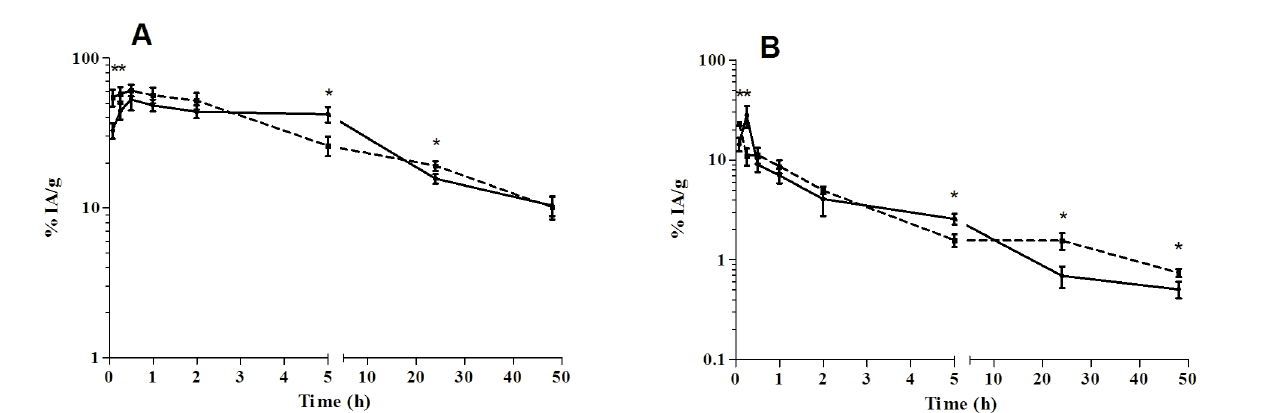
Figure 2 Antimony biodistribution in uninfected [22] and L. ( L. ) amazonensis -infected BALB/c mice after intraperitoneal administration of meglumine antimoniate. A : liver; B : spleen. Continuous line: infected mice; dotted line: uninfected mice. Data are expressed as the mean ± standard deviation (n= 5/time) of the percentage of injected activity (IA) per gram. The significance of differences between uninfected and infected mice was calculated by Student’s t test. * p < 0.05.